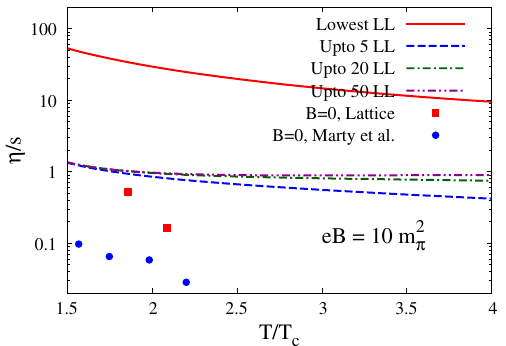
Fig. 5 Thermal conductivity as a function of T / T c at | eB |= 10 m 2 π . Behaviour of λ/ T 2 is comparing with the result at B = 0 of Marty et η/ s al. [47]